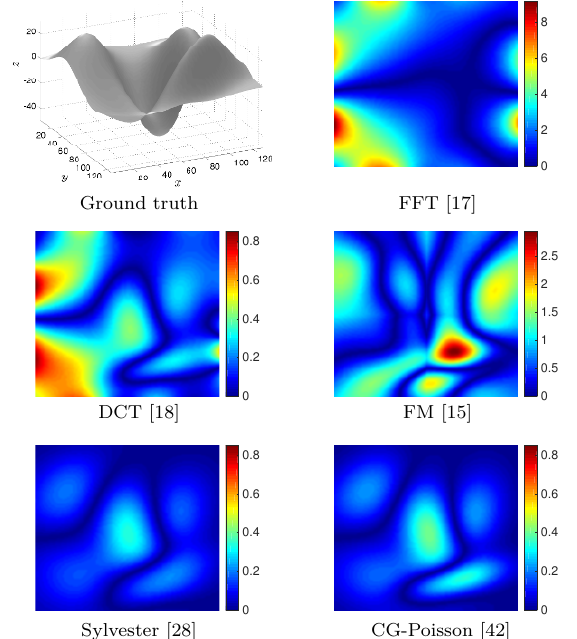
Fig. 6 Absolute errors for the “Peaks” dataset between the ground truth and the numerical result of each method; see Table 3. Note the different scales of the plots. To highlight the differences between all methods we consider three different scales. The absolute error maps of FFT and FM have their own scales due to the fact that the MSE and the maximum error are very different in contrast to the other methods. For DCT, Sylvester, and CG, which have similar values for the MSE and the maximum error, we used the same scale to point out the differences.